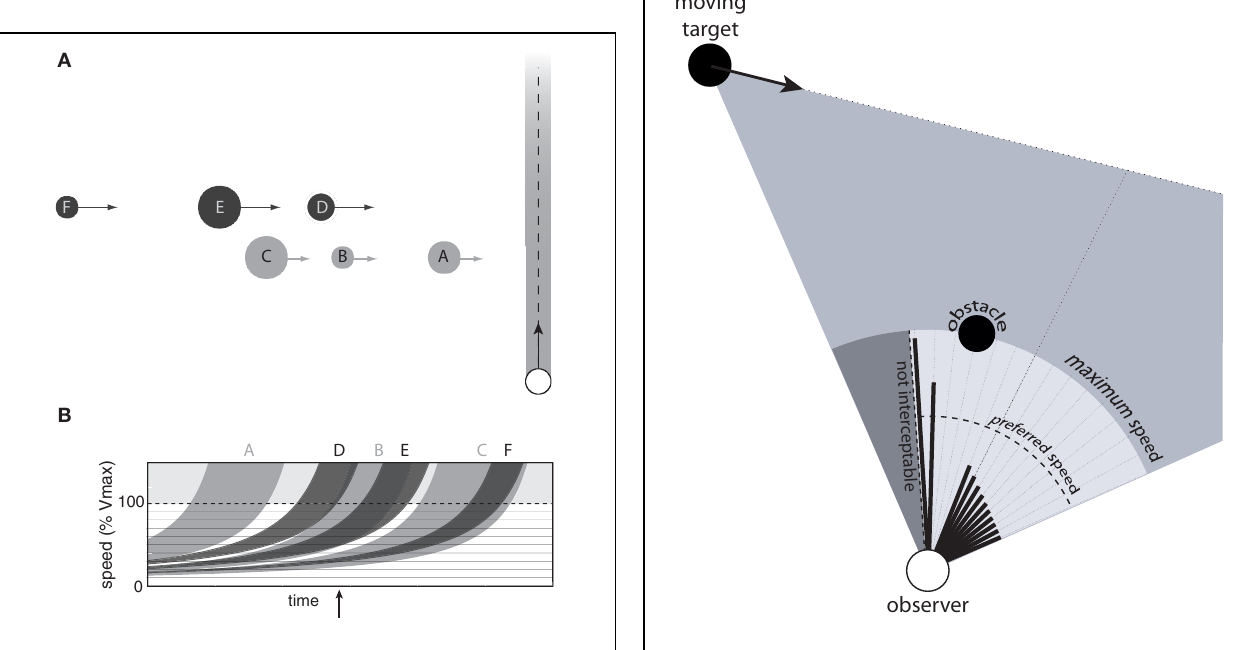
FIGURE 7 | (A) Observer passing through two lanes of obstacles moving at different speeds. (B) Optically specified range of speeds that would result in a collision with each obstacle in the near (light gray) and far (dark gray) lanes as a function of time.